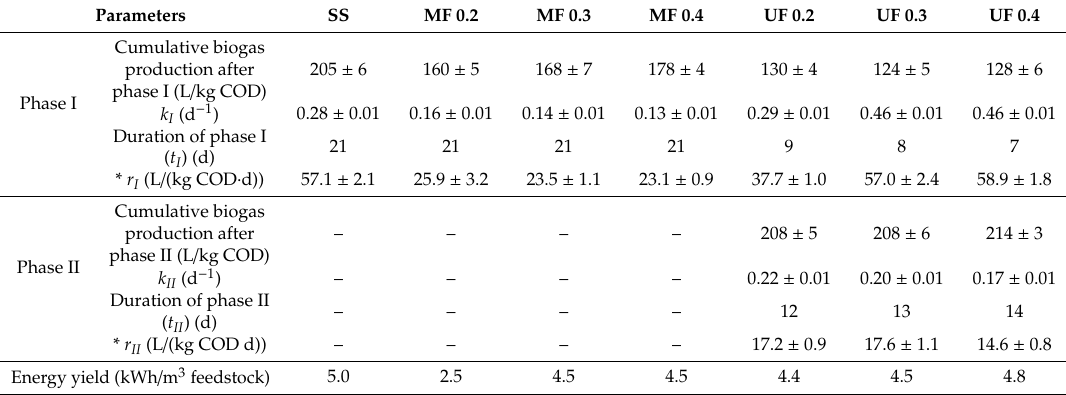
Table 3. Kinetic parameters of biogas production from sewage sludge (SS) and the retentates after MF and UF, and the energy produced from the